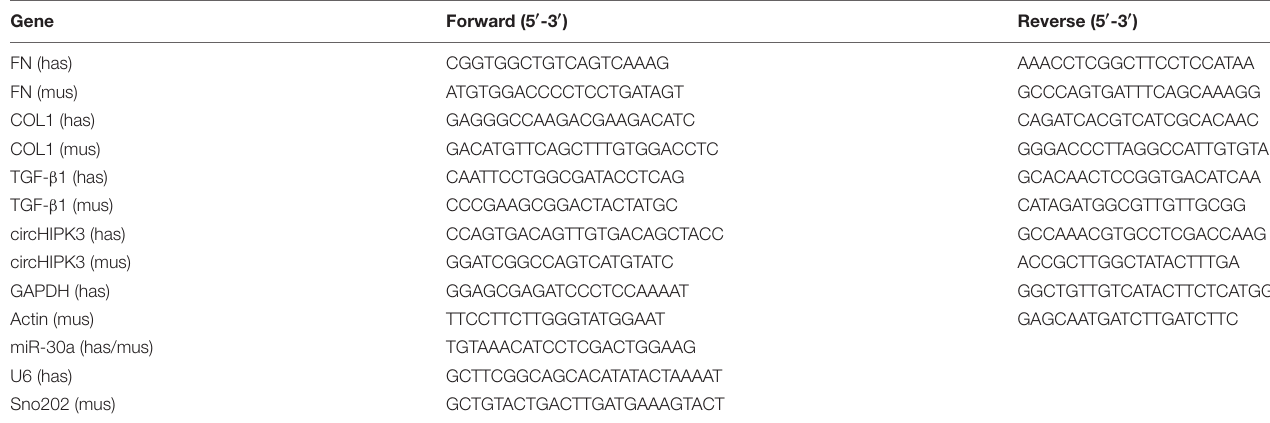
TABLE 2 | Sequences of primers used in real-time quantitative PCR